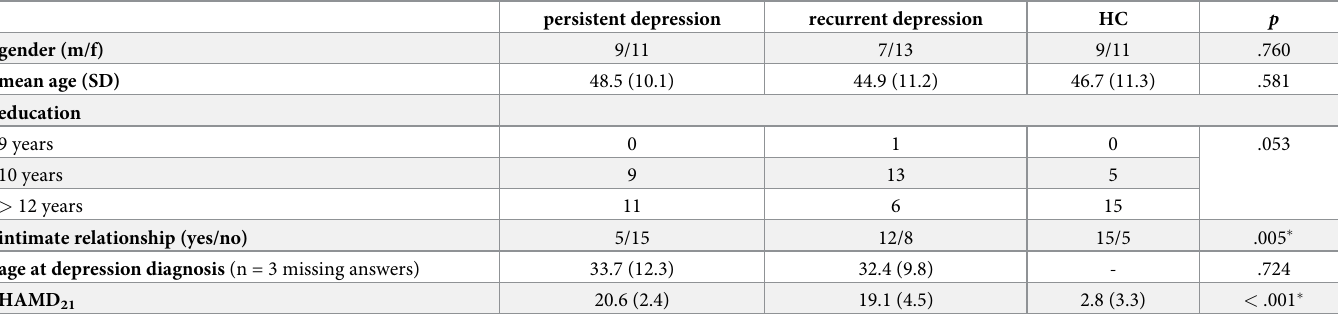
Table 2. Demographic and clinical characteristics of the study